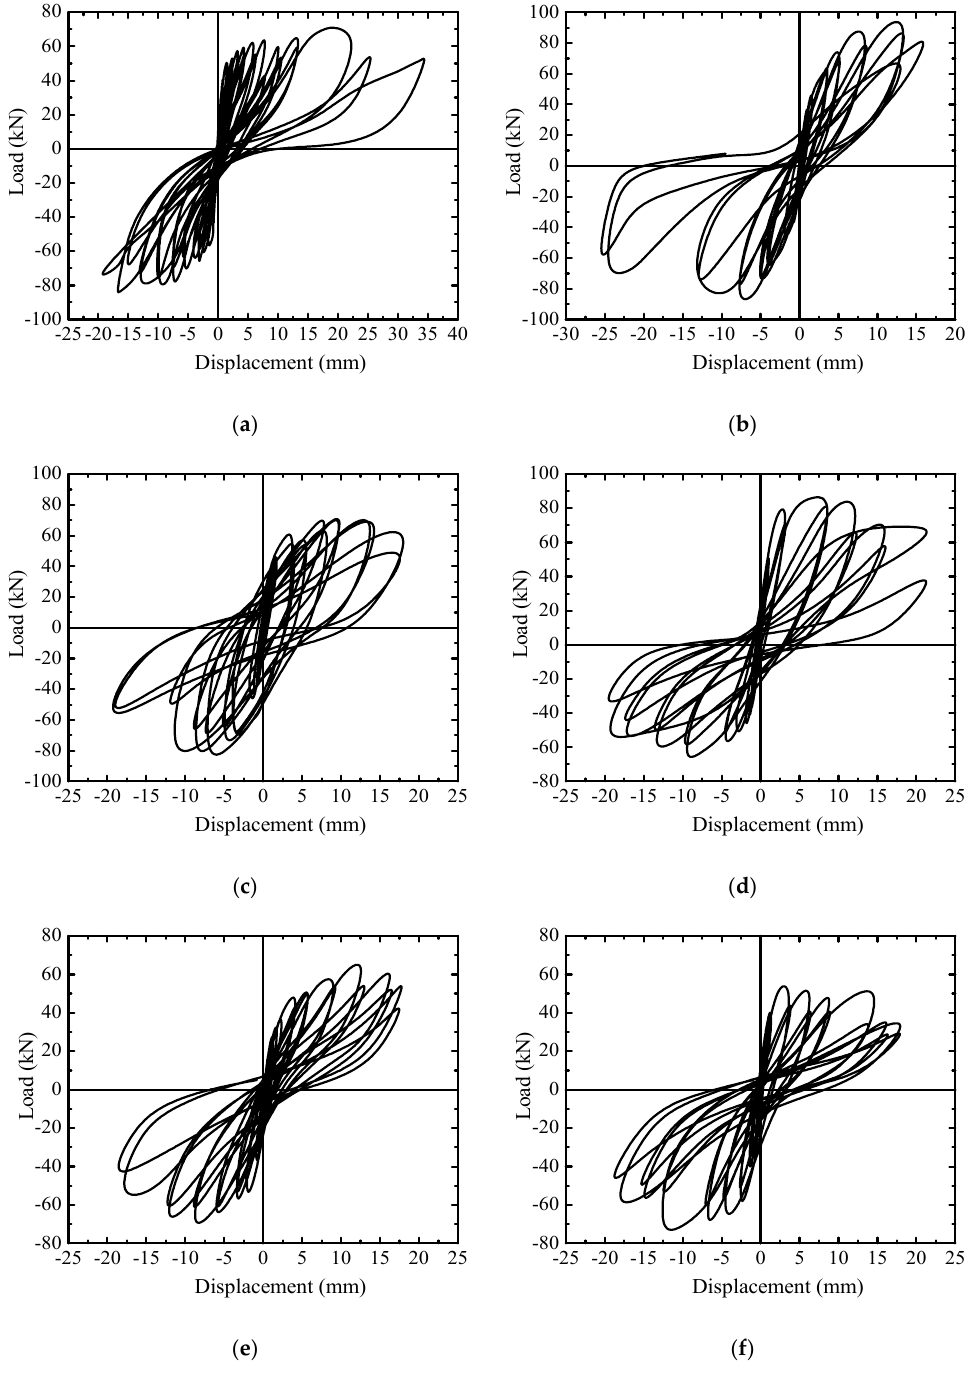
Figure 5. Hysteretic curves of wall specimens: ( a ) R-1; ( b ) R-2; ( c ) M-1; ( d ) M-2; ( e ) Z-1; ( f ) Z-2. The envelopes of hysteretic curves of the walls of each group are presented in Figure 6. The slope of the curves expresses the stiffness of the walls. Typically, the degradation of stiffness was clearly expressed with the increase of displacement. With smaller displacement under the same seismic load, greater sti ff ness of the walls was provided under the higher vertical compressive stress. This fits the normal regularity of the wall subjected to seismic loads as stated in specifications and previous studies [7,8,18,21]. After the peak-load, a larger displacement existed under the continued seismic load. This indicates a good deformability of the walls at damage